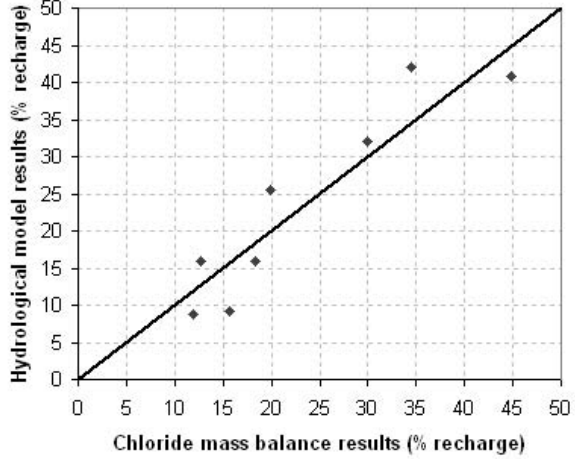
Fig. 8. Groundwater recharge computed by hydrological models versus chloride mass balance